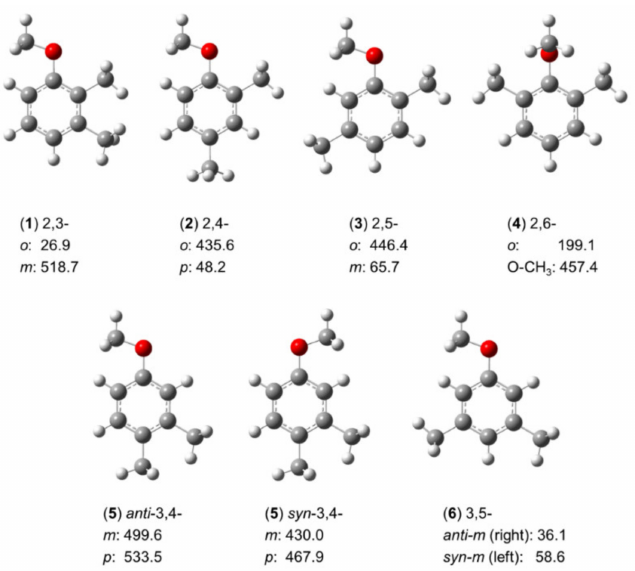
Figure 14. Torsional barriers of the methyl rotors in six isomers of dimethylanisole (in cm − 1 ). ( 1 ) 2,3-dimethylanisole [84], ( 2 ) 2,4-dimethylanisole [82], ( 3 ) 2,5-dimethylanisole [198], ( 4 ) 2,6- dimethylanisole [198,199], ( 5 ) 3,4-dimethylanisole [83], and ( 6 ) 3,5-dimethylanisole [198]. Except for the 2,6-isomer ( 4 ), no splittings arising from the methoxy methyl group are observed, so the molecules are two-top problems. The values of 435.6 cm − 1 and 446.4 cm − 1 found for the barrier height of the methyl rotor at the 2-position of 2,4- ( 2 ) and 2,5-dimethylanisole ( 3 ) are similar [82,198], reflecting well the local steric environment of these methyl groups. The 3-methyl rotor in 3,4-dimethylanisole ( 5 ) with its values of 499.6 cm − 1 in the anti and 430.0 cm − 1 in the syn configurations are intermediate; so are the values observed for the 4-methyl rotor (533.5 cm − 1 and 467.9 cm − 1 , respectively) [83], as well as the 3-methyl rotor in 2,3-dimethylanisole ( 1 ) (518.7 cm − 1 ) [84]. These values indicate the steric hindrance arising from the neighboring methyl group. Methyl